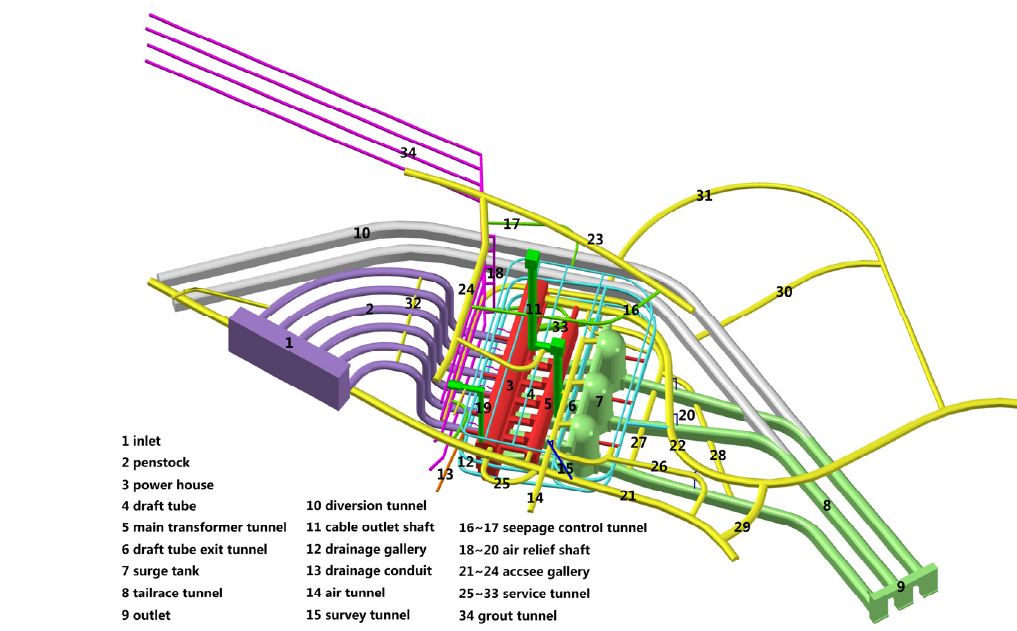
Figure 33. Schematic diagram of the piping system of a hydropower station.